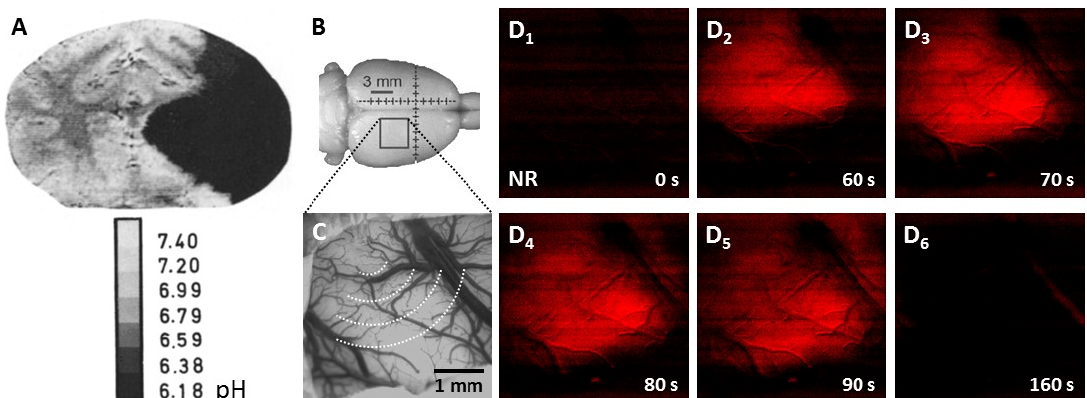
Figure 4. Experimental tissue pH imaging in models of cerebral ischemia and spreading depolarization. ( A ), Umbilliferone fluorescence pH imaging 2 h after experimental middle cerebral artery occlusion in the cat. Reprinted from Csiba et al., 1983 [80], with permission from Elsevier. ( B – D ), Neutral red fluorescenceimagingofspreadingdepolarization(SD)throughaclosedcranialwindowpreparationover the parietal cortex of an anesthetized rat. ( B ), The position of the closed cranial window. ( C ), An intrinsic optical signal image of the exposed cortical surface at green light illumination. The schematic radial hemi-circles indicate the wave of SD. ( D ), Transient tissue acidosis propagating with SD, depicted by the increasing intensity of the Neutral red fluorescent signal (red) in background-subtracted, contrasted and pseudo-colored images. Time with respect to SD initiation is shown in the lower right corner of the